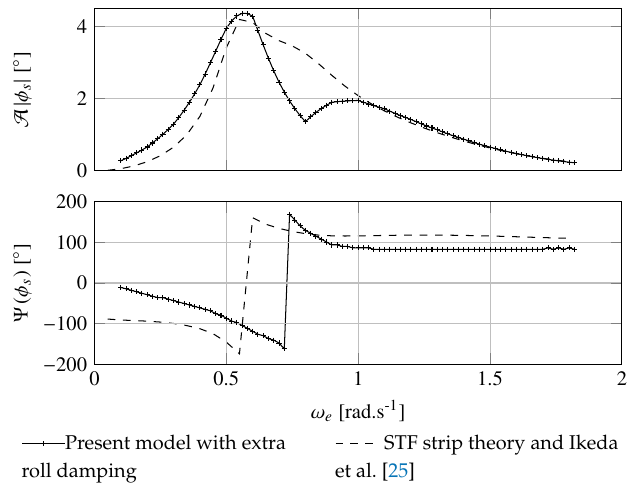
Figure 6. Roll response amplitude operator and phase at U = 7.716 m.s − 1 as function of the frequency of encounter w e with DTMB 5512 at full scale. The results are obtained with the present model and the STF strip theory with the roll damping modeled with the method proposed by Ikeda et al.